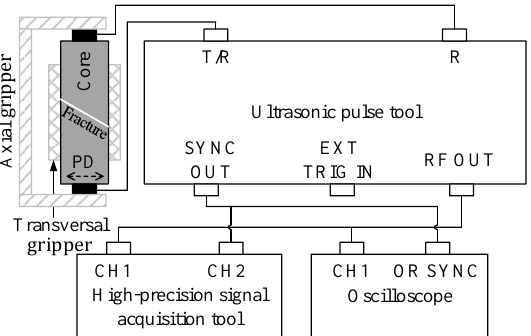
Figure 1. Schematic diagram of experimental measurement of core with oblique fracture. PD is the abbreviation of polarization direction of the shear wave.